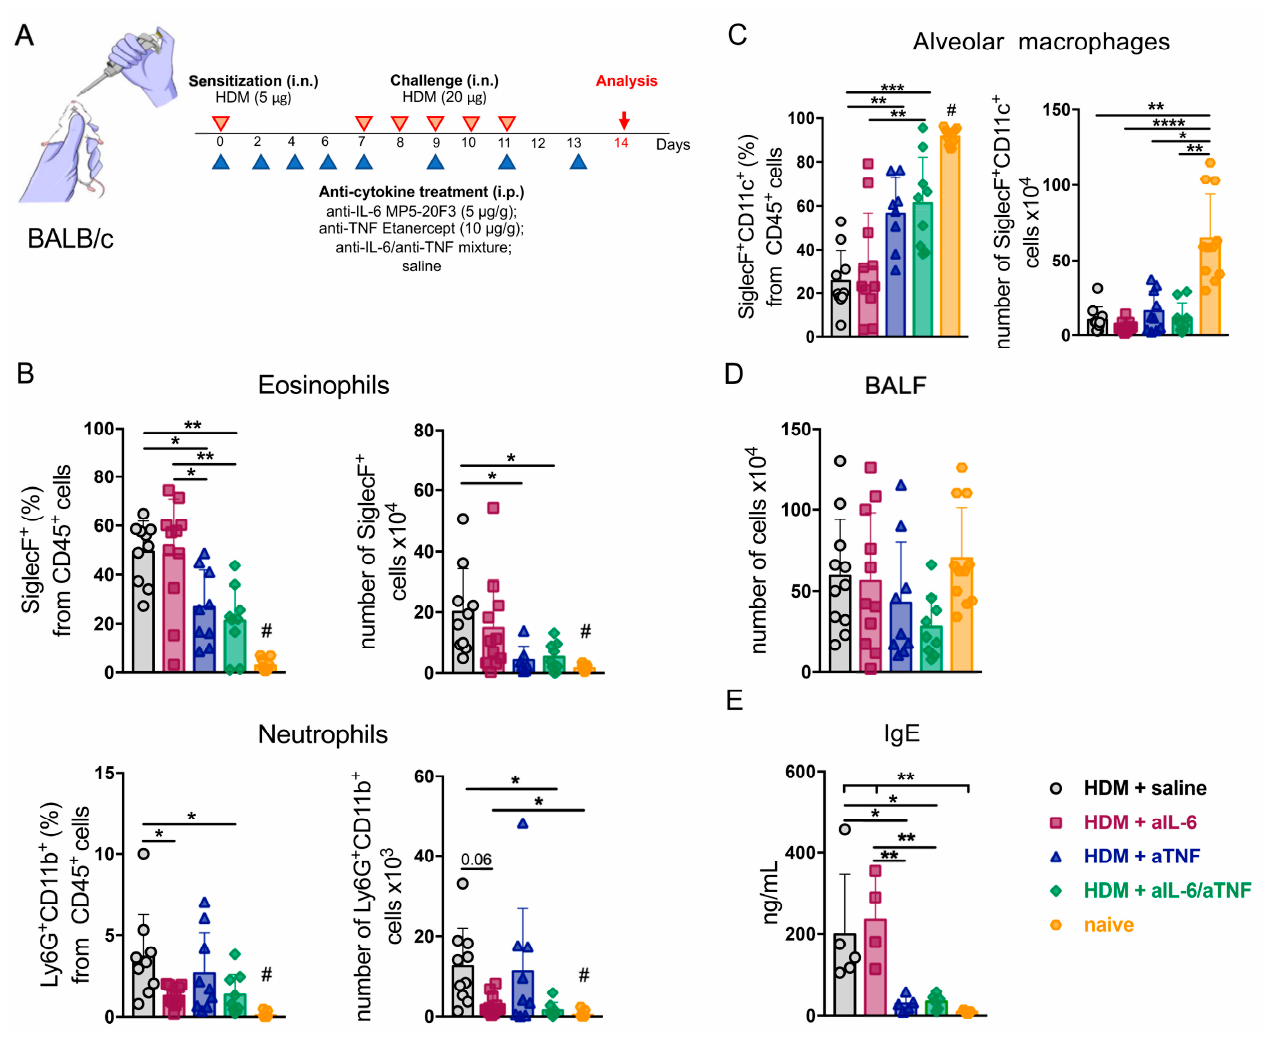
Figure 1. Combined pharmacological inhibition of TNF and IL-6 in acute HDM-induced asthma. ( A ) Scheme of the experiment. Acute asthma was induced in 6–8-week old BALB/c mice by daily i.n. administration of 20 µ g HDM extract per mouse for six days with the sensitization of 5 µ g HDM one week prior to the main course (red arrows). Anti-IL-6 antibody (MP5-20F3) (5 µ g/g of body weight), anti-TNF inhibitor (Etanercept) (10 µ g/g of body weight), and saline as a control were administered i.p. every 48 h for 13 days according to the scheme (blue arrows). Prior to i.n. administration of HDM, mice were anesthetized by 3% isoflurane delivered with oxygen. BALF was collected for analysis 48 h after the last challenge. Frequencies (%) of eosinophils (Siglec-F + CD11c − ), neutrophils (Ly6G + CD11b + ) ( B ) and alveolar macrophages (SiglecF + CD11c + ) ( C ) gated on CD45 + live cells in the BALF were assessed by flow cytometry. ( D ) Total cell numbers in the BALF. ( E ) IgE production (ng/mL) in the BALF was determined by ELISA on day 14. Each point on a diagram represents a single mouse (5–12 mice in each group); mean ± SD. * p < 0.05; ** p < 0.01; *** p < 0.001; **** p < 0.0001; #—**** p < 0.0001 (naïve vs. HDM + saline), *** p < 0.001 (naïve vs. HDM + aIL-6), ** p < 0.01 (naïve vs. HDM + aTNF); * p < 0.05 (naïve vs. HDM + aIL-6/aTNF) (one-way ANOVA test was used). HDM, house dust mite; BALF, bronchoalveolar lavage